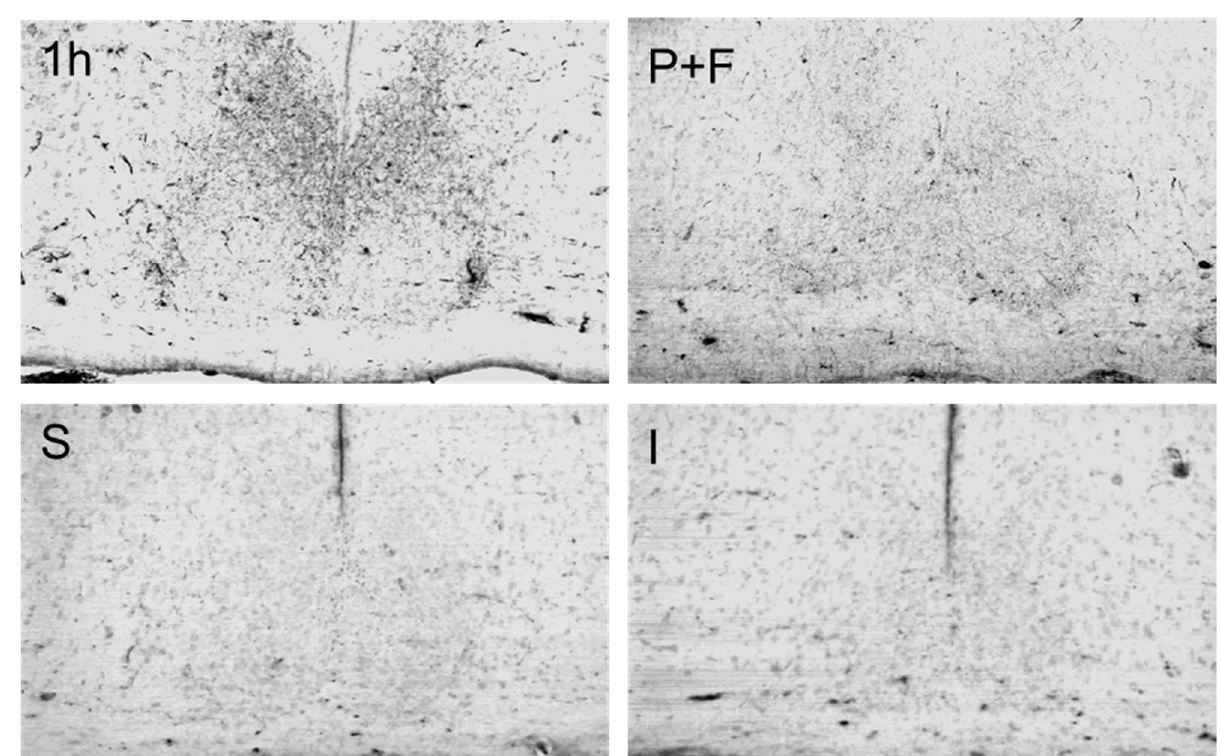
Figure A1. Arginine-vasopressin immunoreactivity in the suprachiasmatic nuclei of Syrian hamsters. Comparison between 1 h manual sleep deprivation (1 h, group 3a), sexual stimulation with pheromone and females (P+F, group 1), sleep (S, group 5) and immobilization stress (I, group 4). Magnification: 50×.